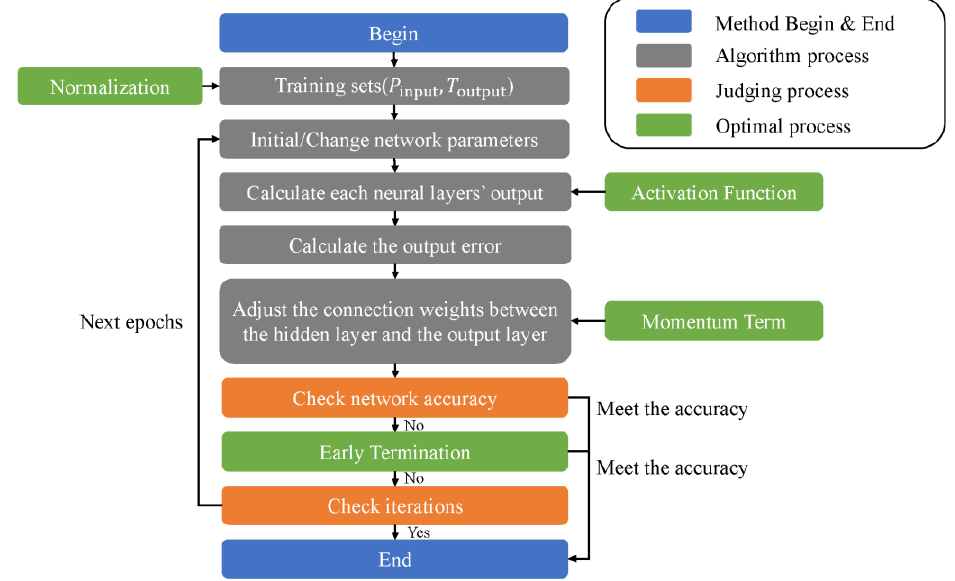
Figure 3. Flowchart of the methodology of the back propagation neural network.